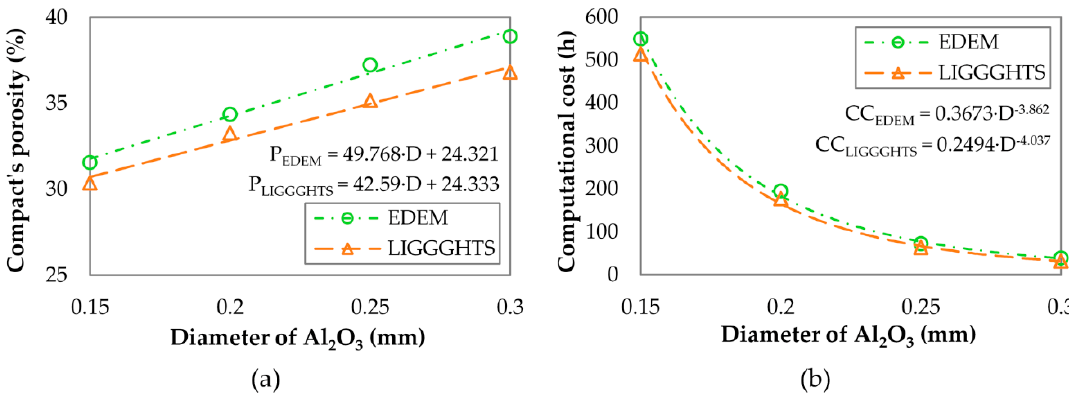
Figure 6. Effect of the particle size of Al 2 O 3 on ( a ) the compact’s porosity and ( b ) the computational Figure 6. E ff ect of the particle size of Al2O3 on ( a ) the compact’s porosity and ( b ) the computational cost.